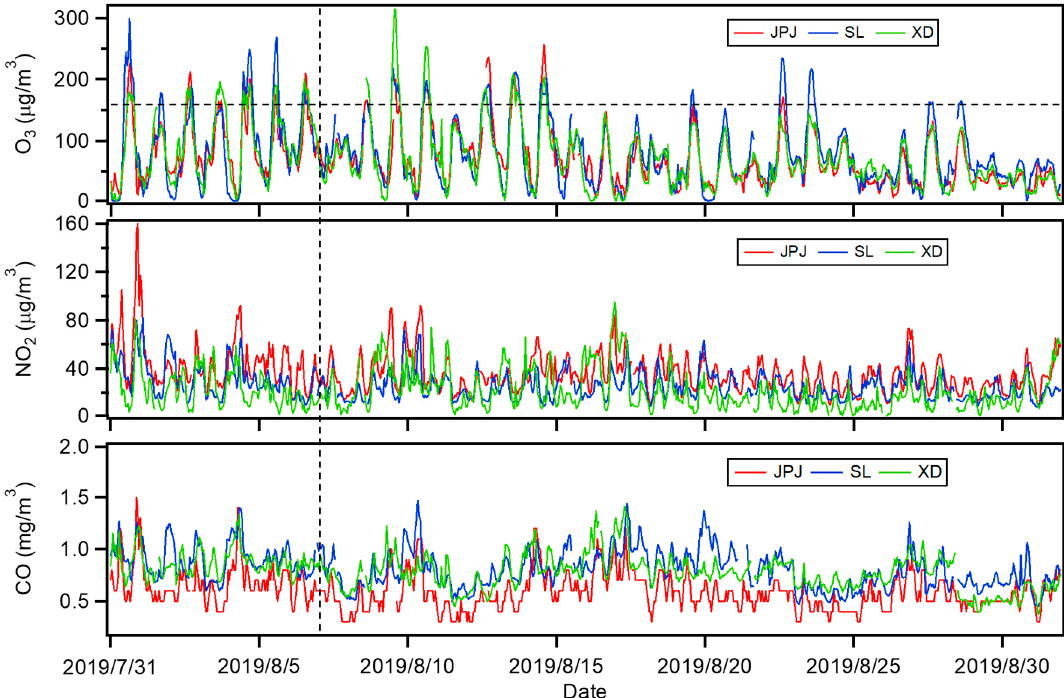
Figure 2. Temporal profiles of O 3 , NO 2 and CO concentrations at each site (red line: JPJ; blue line: SL; green line: XD). The horizontal dashed line in the first panel indicates the O 3 standard Grade II, i.e., 160 µ g / m 3 . The vertical dashed line represents when the control strategy was implemented.